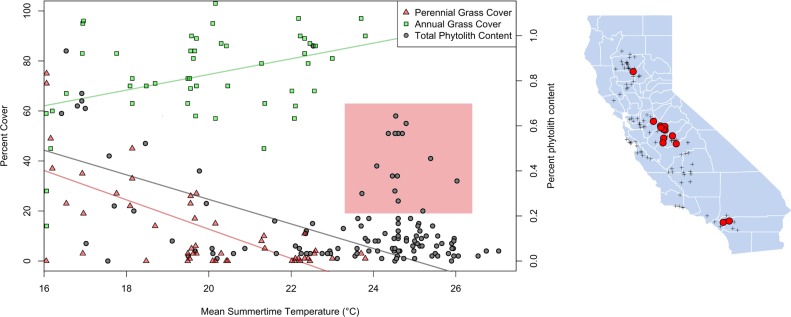
Relationship between mean summertime temperature and modern grass cover [24] as well as phytolith content [10]. Regression line for phytoliths based on data restricted to the region of points from Clary [24]. Points within shaded box are shown at right as red circles against other phytolith samples (black crosses).